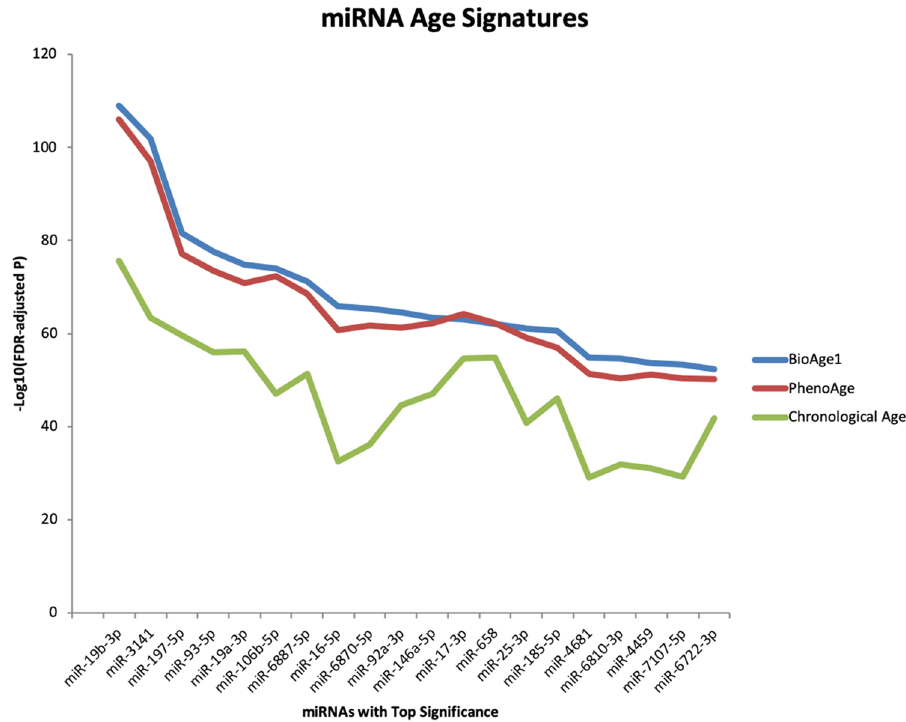
p-values at the − Log10 scale, when the association was assessed for BioAge1 (blue), PhenoAge (red) and Chronological Age